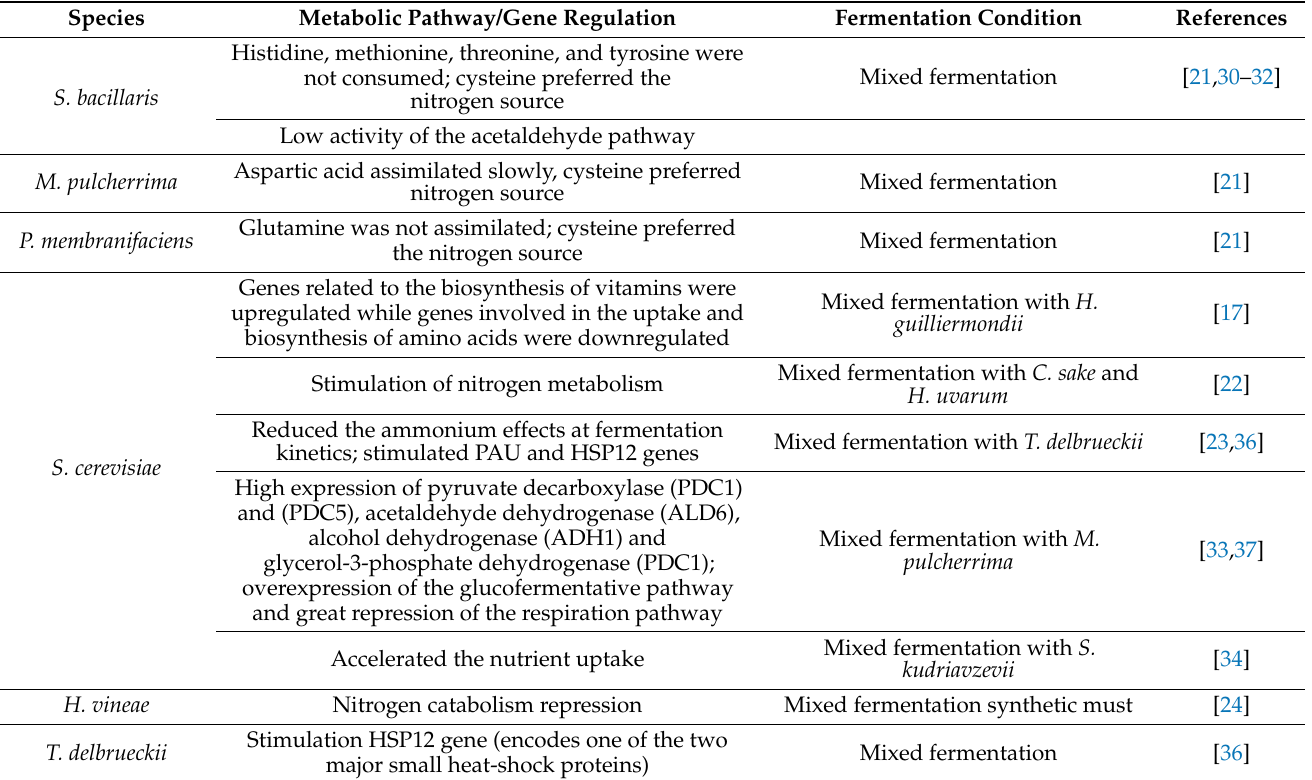
Table 1. The main metabolic response in yeast–yeast